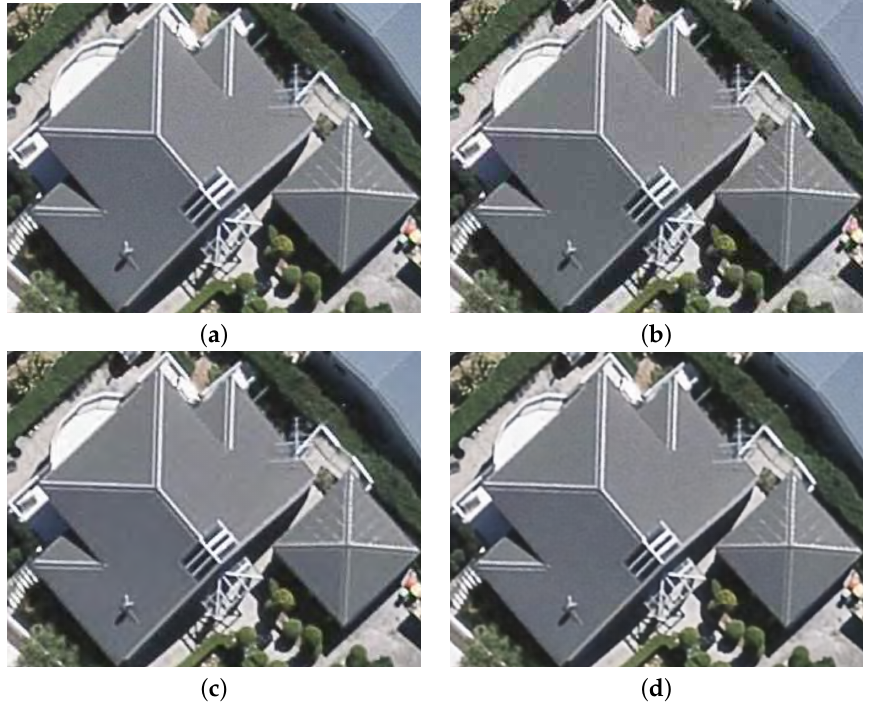
Figure 9. The visual performance. JPEG: 0.7712 bpp, PSNR 31.07 dB, MSSSIM 0.9788. JPEG2000: 0.7373 bpp, PSNR 33.72 dB, MSSSIM 0.9814. Ours: 0.6818 bpp, PSNR 35.18 dB, MSSSIM 0.9897.